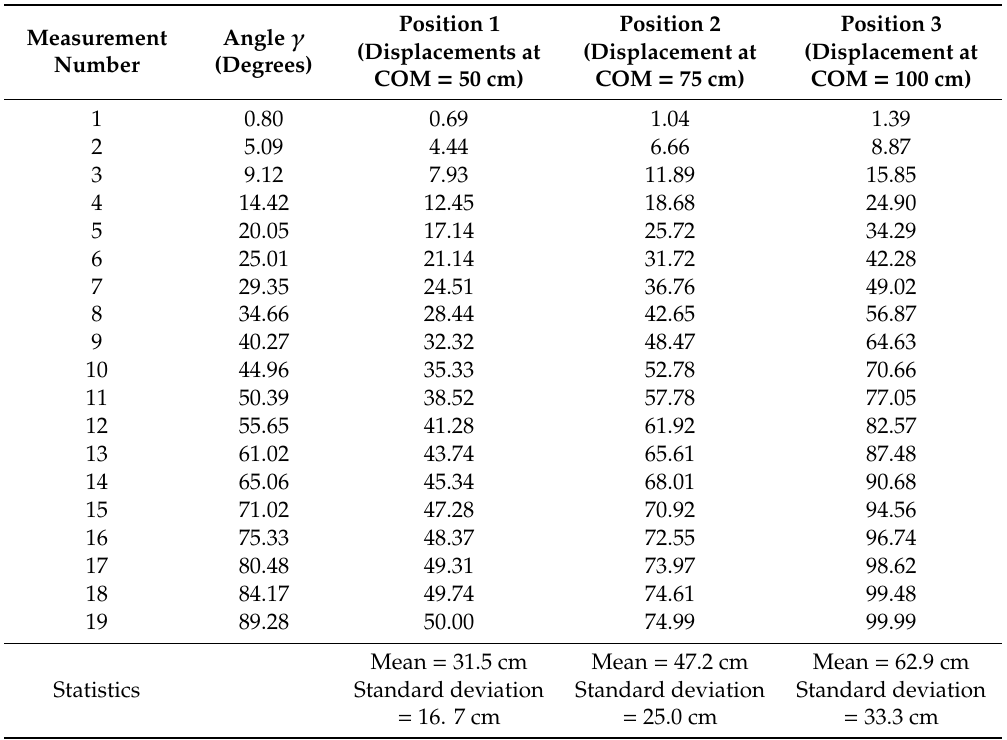
Table 2. Accelerometry measurements.